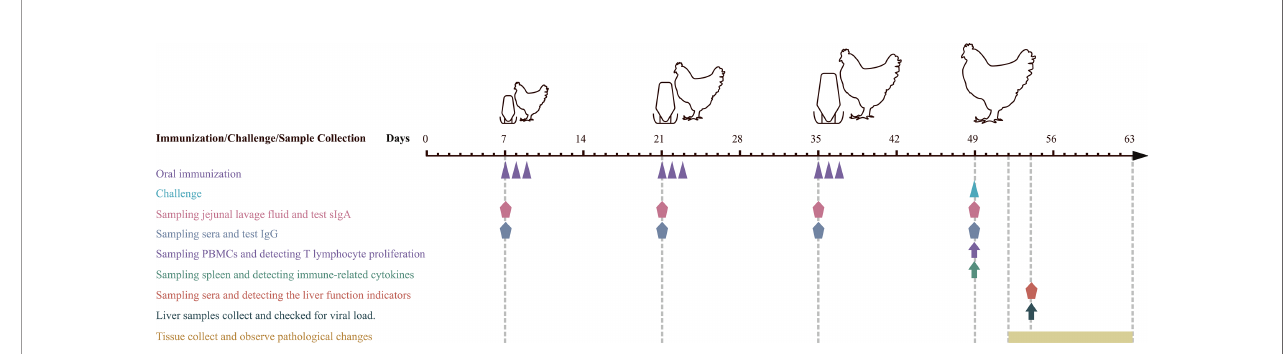
FIGURE 2 | Schematic diagram of immune, sampling, and challenge procedure. Oral immunization with recombinant probiotics L. lactis and E. faecalis at 7, 8, and 9, 21, 22, and 23, 35, 36, and 37 days of age. Infection experiments were carried out at 49 days of age. Sera and jejunal lavage fl uid samples were collected at 7, 21, 35 (before vaccination), and 49 (before challenging). Sera from chickens in each group were collected on day 5 postinfection (dpi) to detect the liver function indicators. Liver samples were collected at 5 dpi to detect in fl ammatory factors and viral load. Euthanasia and autopsy were performed on 3 dpi to observe gross pathological lesions and